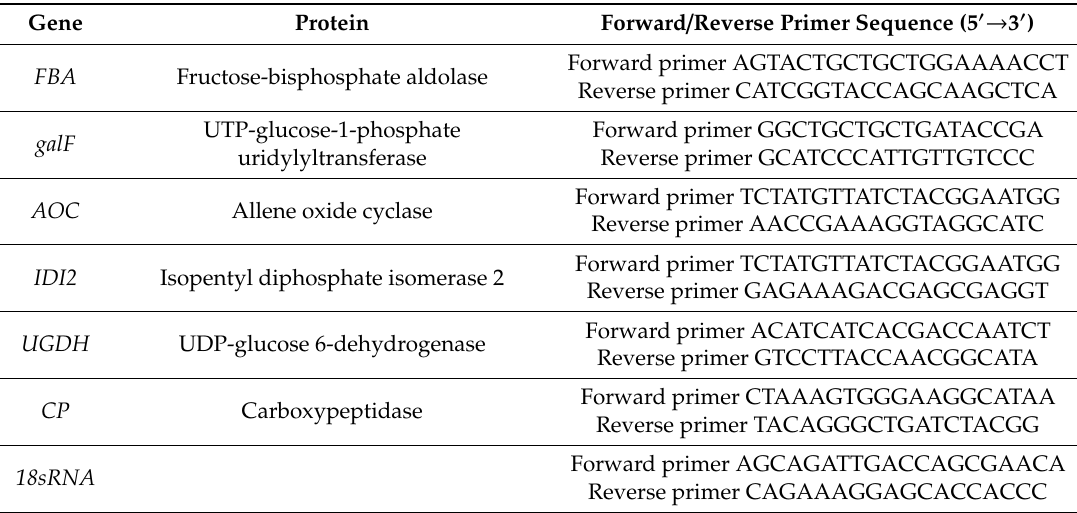
Table 3. Genes and primers used for quantitative